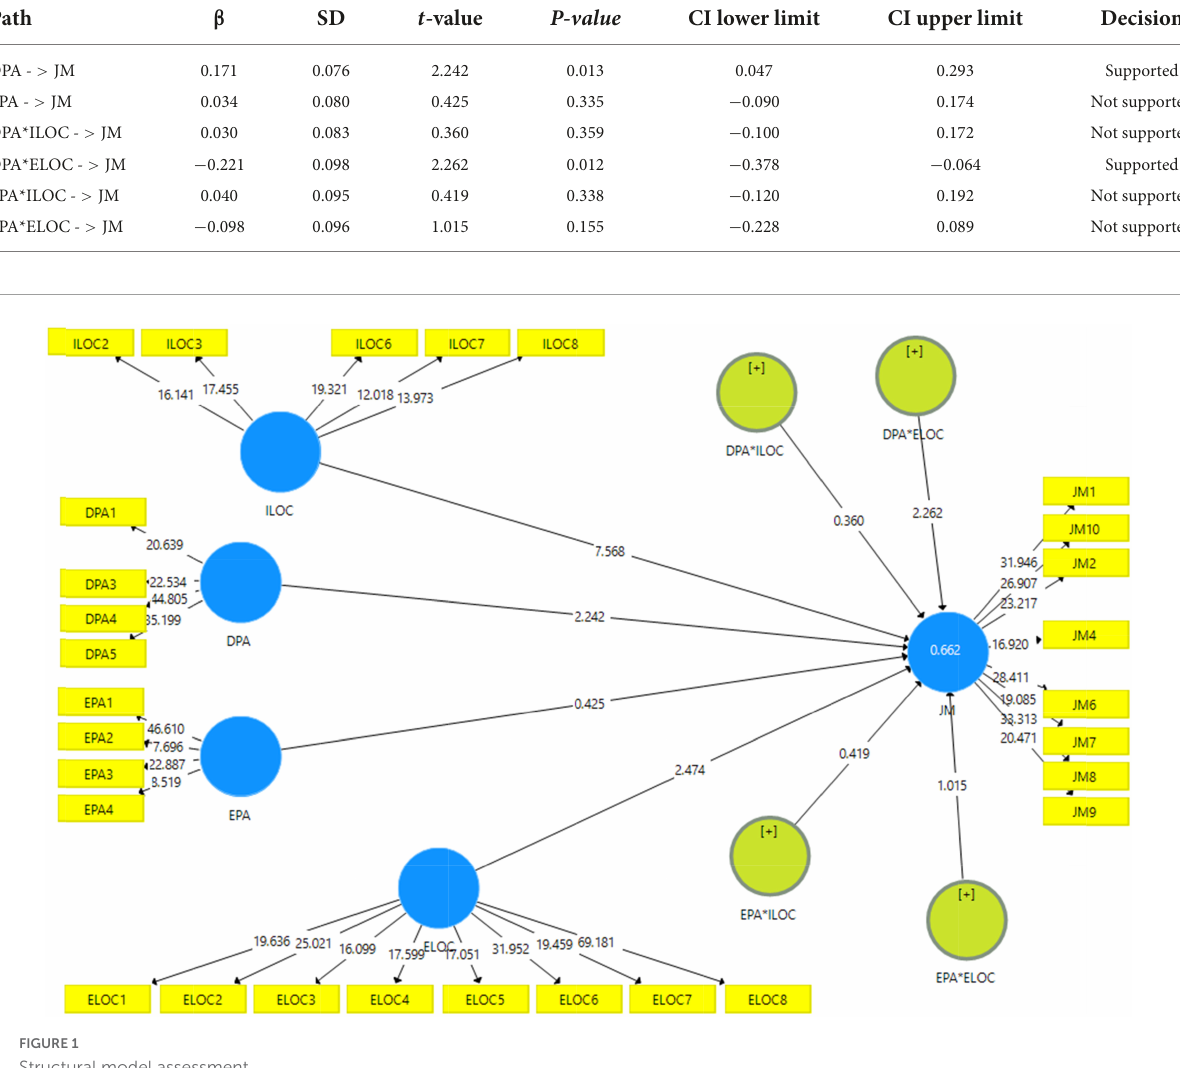
TABLE 7 Results of structural model.